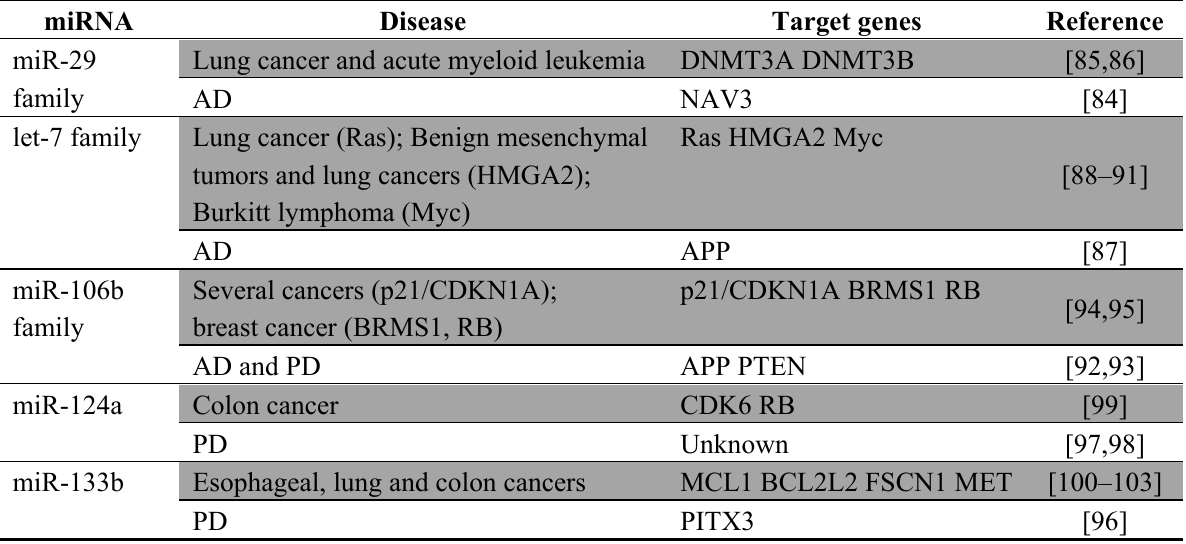
Table 5. Pathways controlled by the same miRNA (distinct in cancer and neurodegenerative